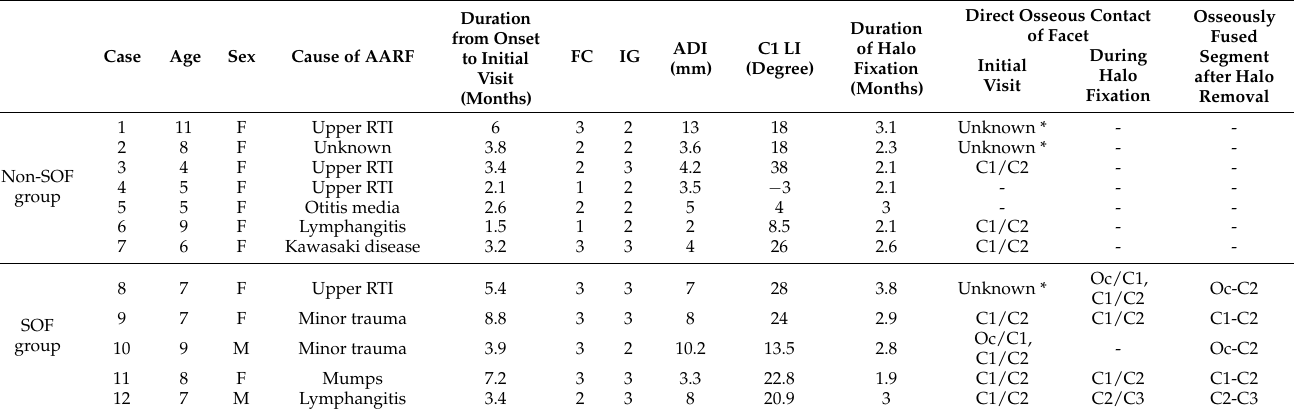
Table 1. Patient Characteristics.